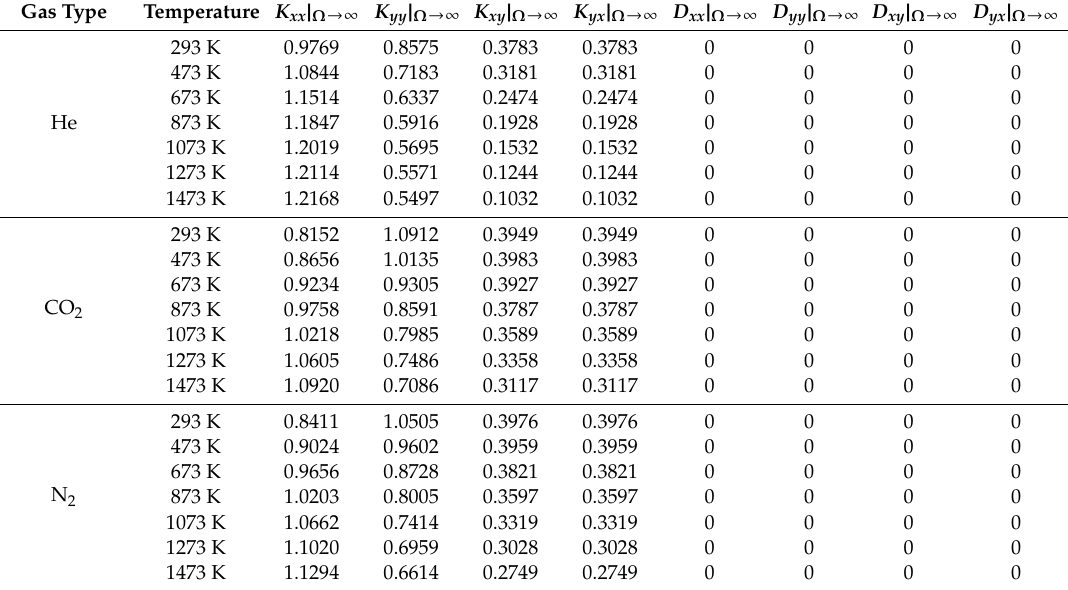
Table 2. + ∞ dynamic limit coe ffi cients of di ff erent kinds of